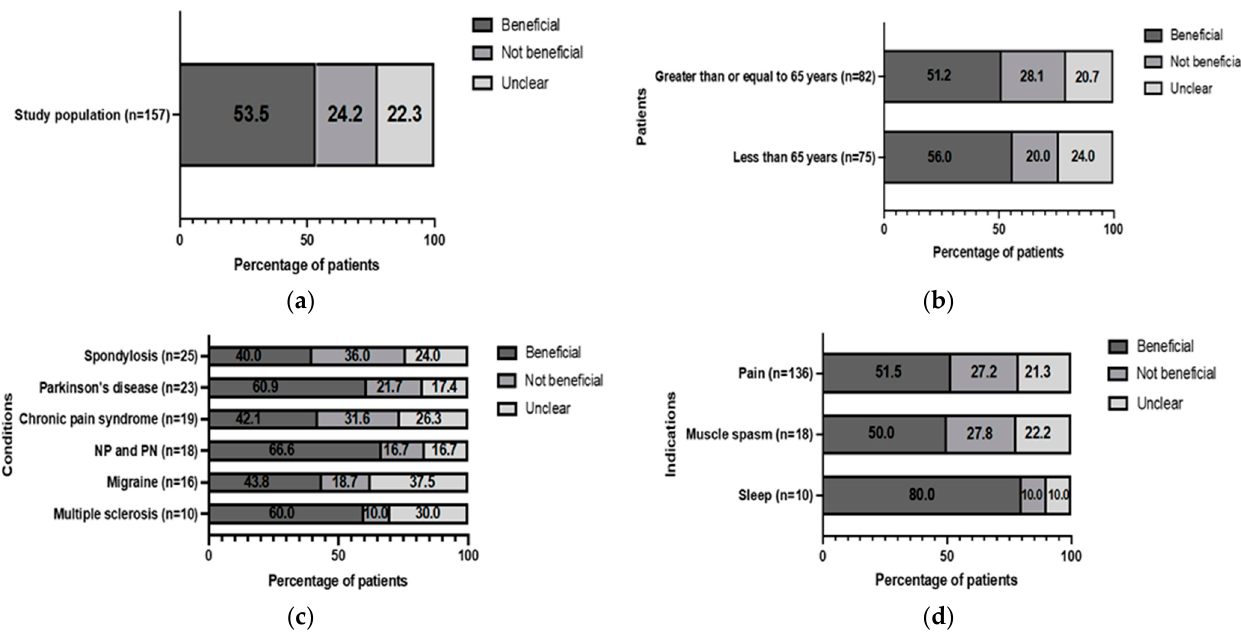
Figure 1. Patient-perceived benefit of medicinal cannabis treatment: ( a ) overall (regardless of con- dition or indication); ( b ) comparing <65 years and ≥ 65 years; ( c ) by condition; ( d ) by indication. NP: neuropathic pain; PN: peripheral